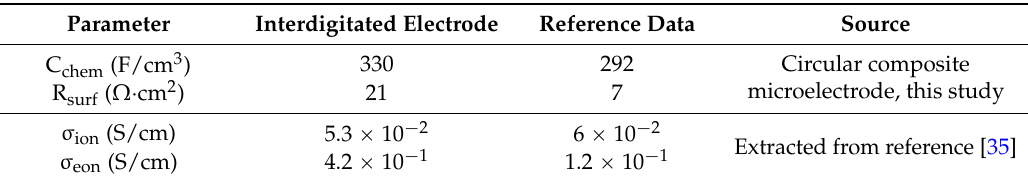
Table 1. Comparison of material parameters of GDC 10 gathered on model-composite electrodes with interdigitated current collectors, cf. reference [25], to circular model-composite electrodes or literature values, respectively. The interdigitated current collectors had a width and spacing of both 30 µ m and a length of 980 µ m, cf. Figure 2. The current collector for the circular composite microelectrode was a grid of 10 µ m width and 10 ˆ 10 µ m 2 holes, cf. Figure 1a. Both current collectors were Pt buried beneath a 200 nm thick GDC layer. Measurements were performed at 750 ˝ C in ~2.5% vol H 2 /~2.5% vol H 2 O/balance Ar. Literature values are averaged for measurements in